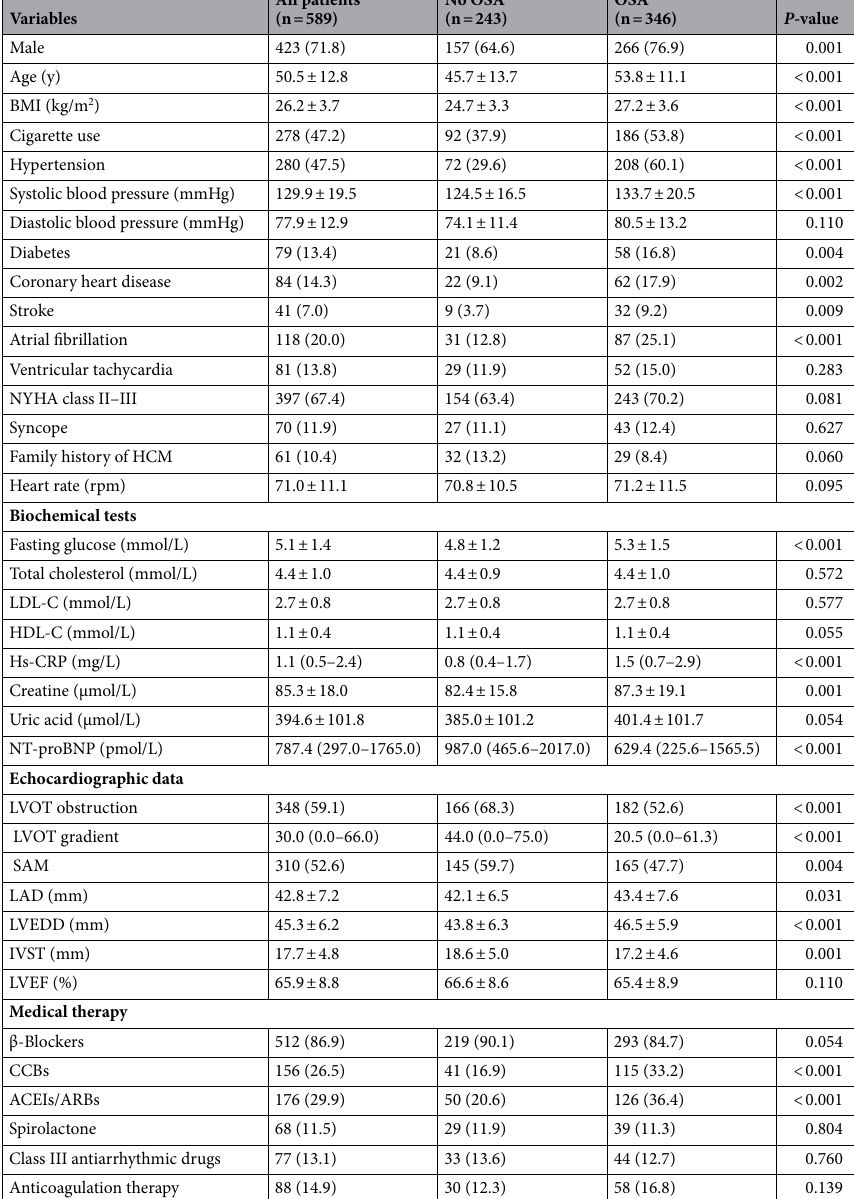
Table 1. Clinical characteristics of patients with HCM grouped according to the presence of OSA. Values are presented as mean ± standard deviation, as median (interquartile range), or as n (%). HCM: hypertrophic cardiomyopathy; OSA: obstructive sleep apnea; BMI: body mass index; NYHA: New York Heart Association; LDL-C: low-density lipoprotein cholesterol; HDL-C: high-density lipoprotein cholesterol; hs-CRP, high- sensitivity C-reactive protein; NT-proBNP: N-terminal pro-B-type natriuretic peptide;LVOT: left ventricular outflow tract; SAM, systolic anterior motion; LAD: left atrial diameter; LVEDD: left ventricular end- diastolic dimension; IVST: Interventricular septum thickness; LVEF: left ventricular ejection fraction; PSG: polysomnography; AHI: apnea hypopnea index; ODI: oxygen desaturation index; SaO 2 : oxygen saturation; TST: total sleep time; HR: heart rate; CCBs: calcium channel blockers; ACEIs: angiotensin-converting enzyme inhibitors; ARBs: angiotensin II receptor